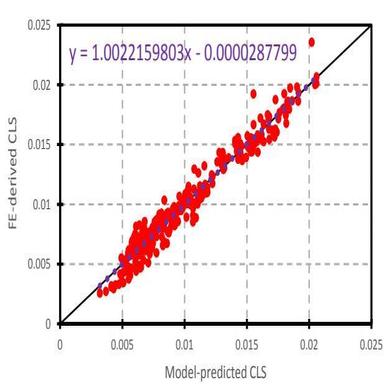
RHT Model prediction vs. FEA.